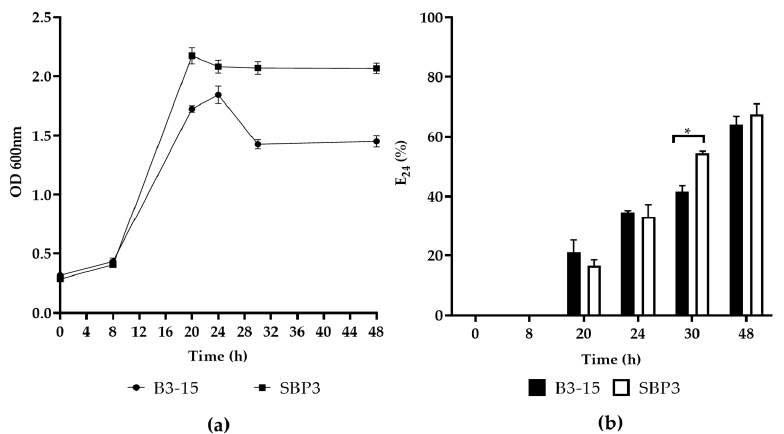
0.4) (groups b) (Figure 2a).